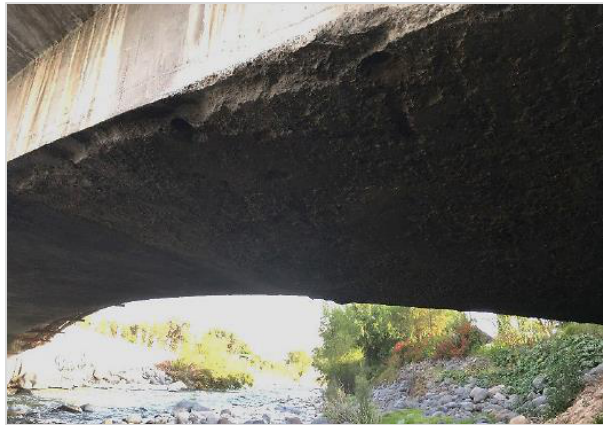
Figure 1. Surveying of the bridge.